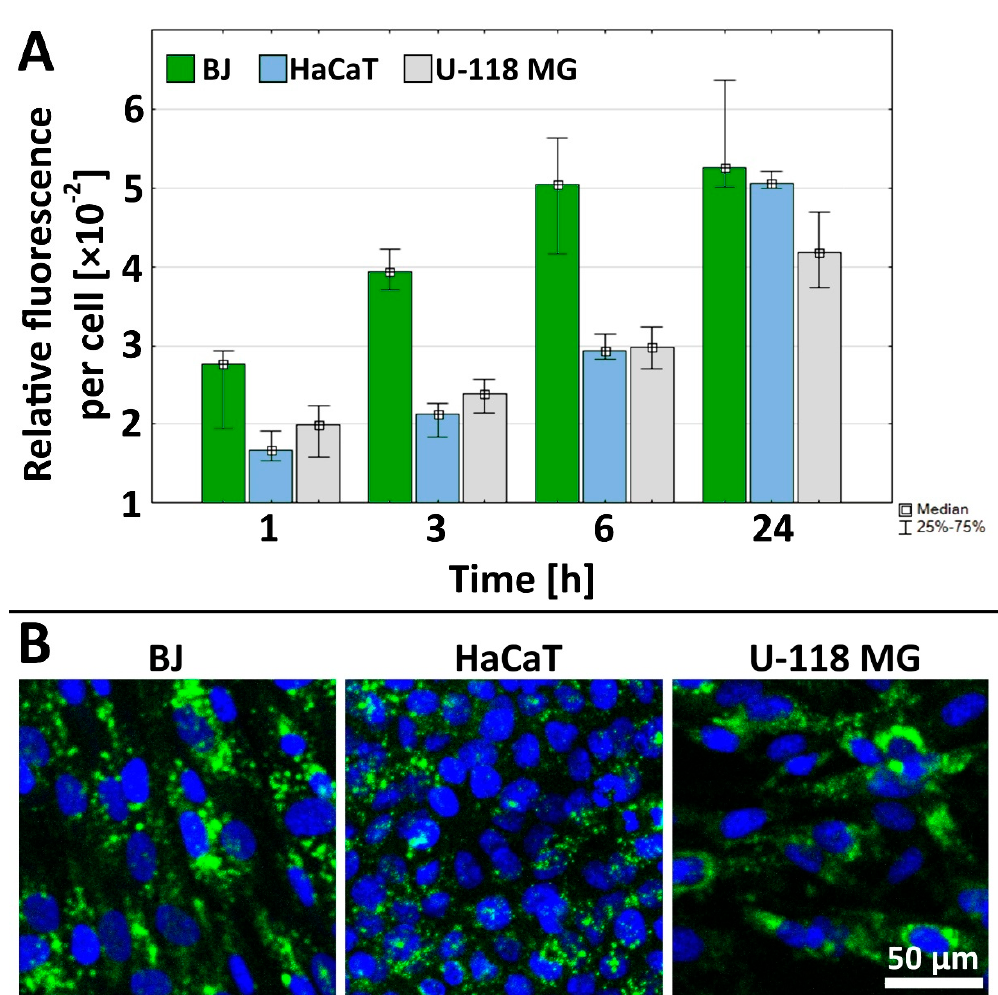
Figure 3. ( A ) Time–dependent cellular accumulation of 0.1 µM G3-BCLF conjugate in BJ, HaCaT and U-118 MG cells. Results are presented as median of triplicate assays from three independent experiments and expressed as a fluorescence signal (relative fluorescence units) per cell. The whiskers are lower (25%) and upper (75%) quartile ranges. ( B ) Representative images of the accumulation of G3-BCLF conjugate after 24 h incubation (green signal) and DAPI labeled nuclei (blue signal).